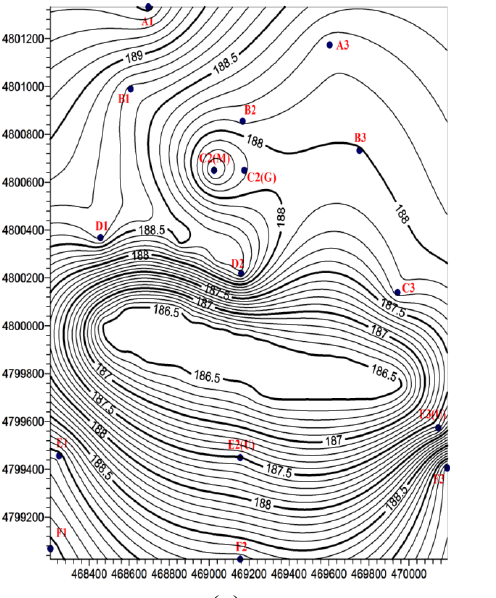
( e ) ( f ) Figure 2. Contour plots of: ( a ) annual mean annual water table; ( b ) topography; ( c ) annual mean spring water table; ( d ) annual mean summer water table; ( e ) annual mean fall water table; and ( f ) annual mean winter water table. The units are in m and dots signify the sampling wells. Table 3. Mean annual water table levels in the study